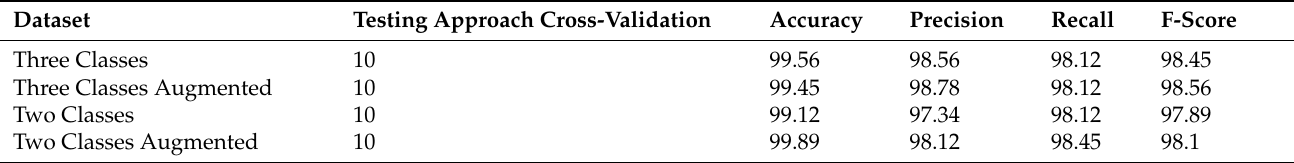
Table 4. Results of different datasets using the proposed